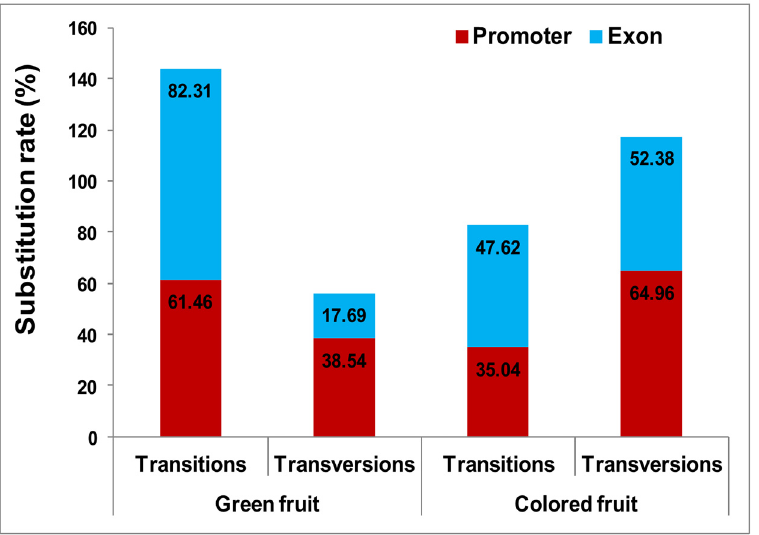
Fig 4. Frequency of transition/transversion ratios in CYC-B gene and promoter. Green fruited accessions have more transitions, whereas, coloured fruited accessions carry more transversions.